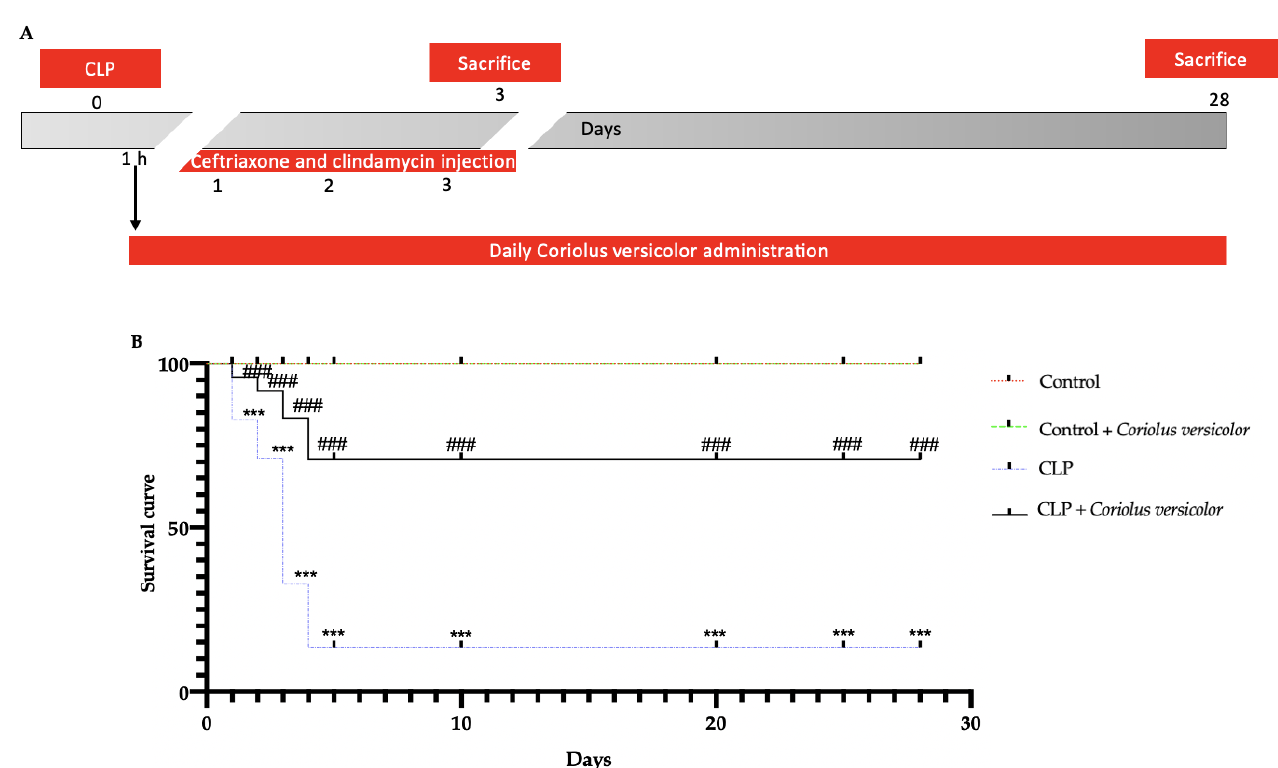
Figure 1. Coriolus versicolor reduced CLP-induced mortality: Experimental timeline ( A ), Percent survival ( B ). For these analysis n = 10 animals for each group were employed. Results were analyzed by Log-rank (Mantel-Cox) test. A p -value of less than 0.05 was considered significant. *** p < 0.001 vs. Control, ### p < 0.001 vs. CLP.